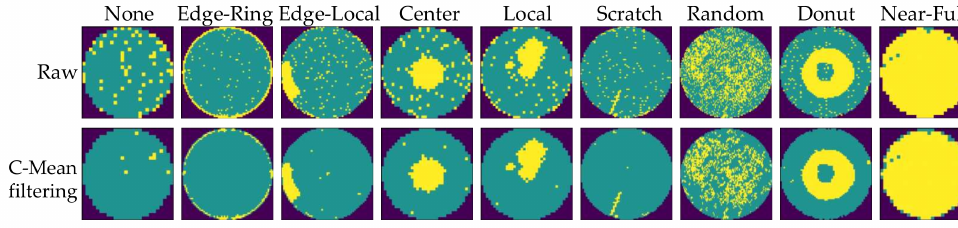
Figure 3. Results of C-mean filtering for wafer maps.